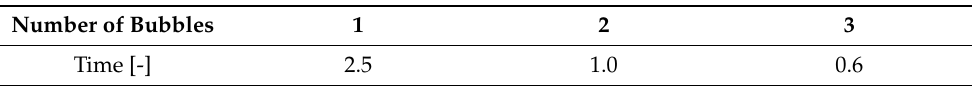
Table 6. Times when the pressure waves first contacted the bubble surfaces.